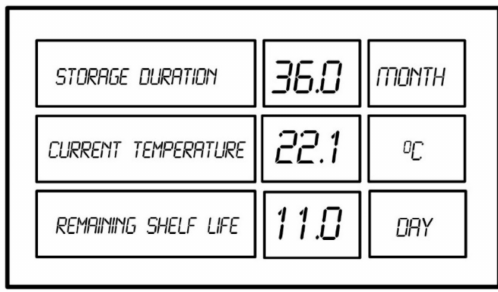
Figure 11. Online information concerning the remaining shelf life received from the data logger.